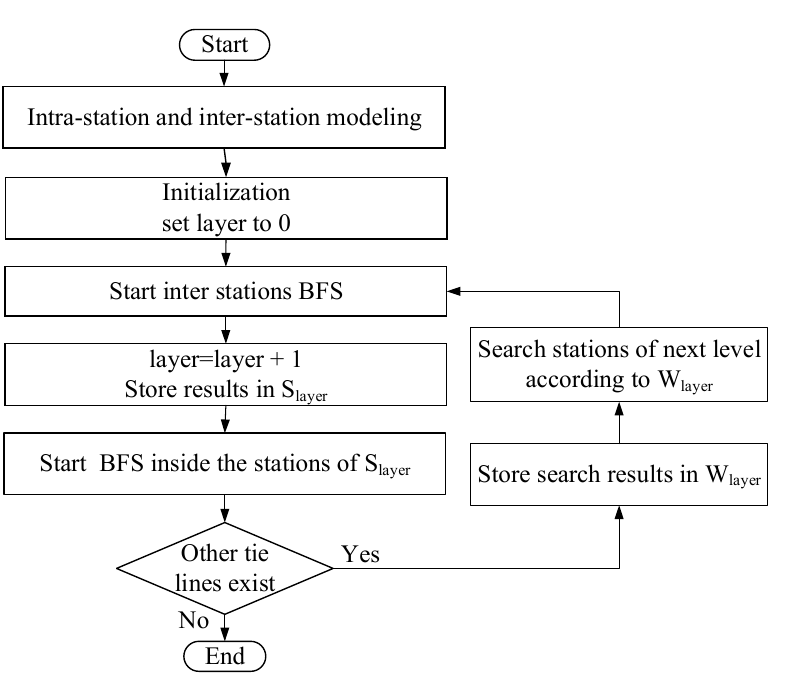
Figure 4. Path search algorithm between and inside